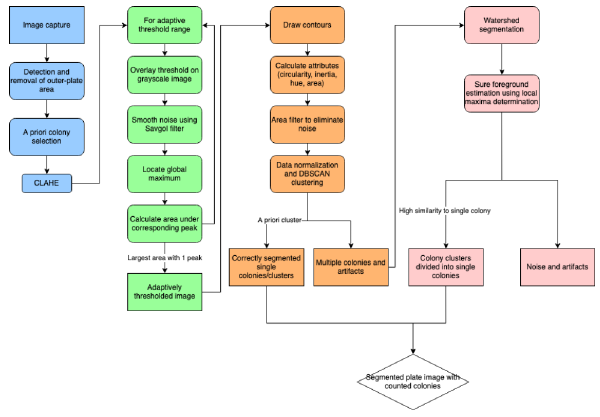
Fig. 1 Flowchart of colony segmentation